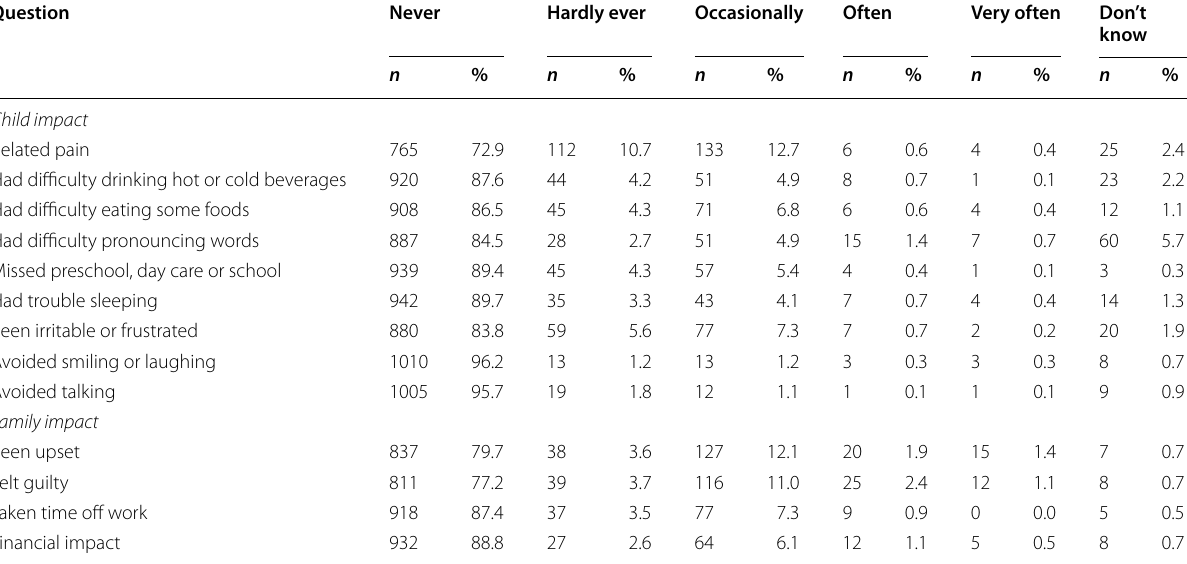
Table 2 Descriptive analysis of questions related to the B-ECOHIS questionnaire ( n